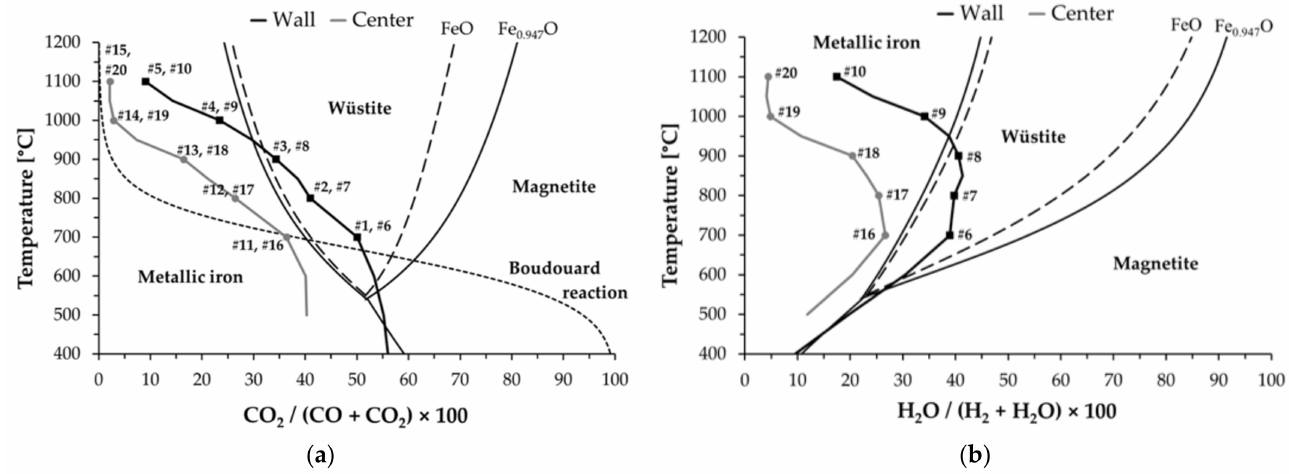
Figure 3. Experimental conditions shown in Baur-Glaessner diagrams in relation to ( a ) etaCO, and ( b ) etaH 2 .